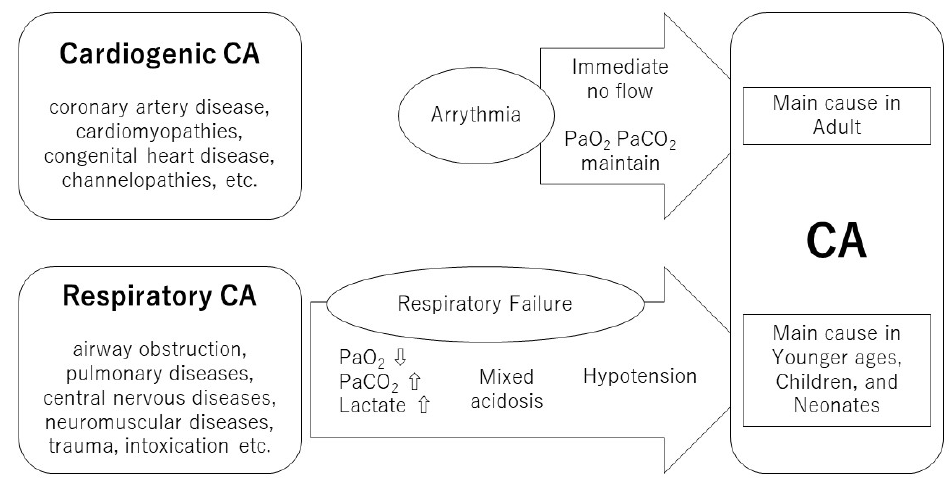
Figure 1. The di ff erences between cardiogenic and respiratory CA. CA, cardiac